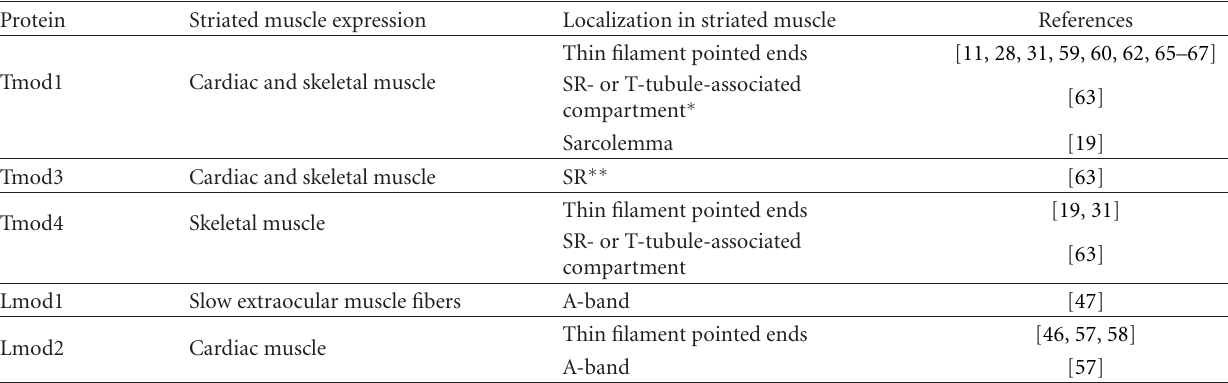
Table 1: Expression and localization of Tmods and Lmods in striated muscle.